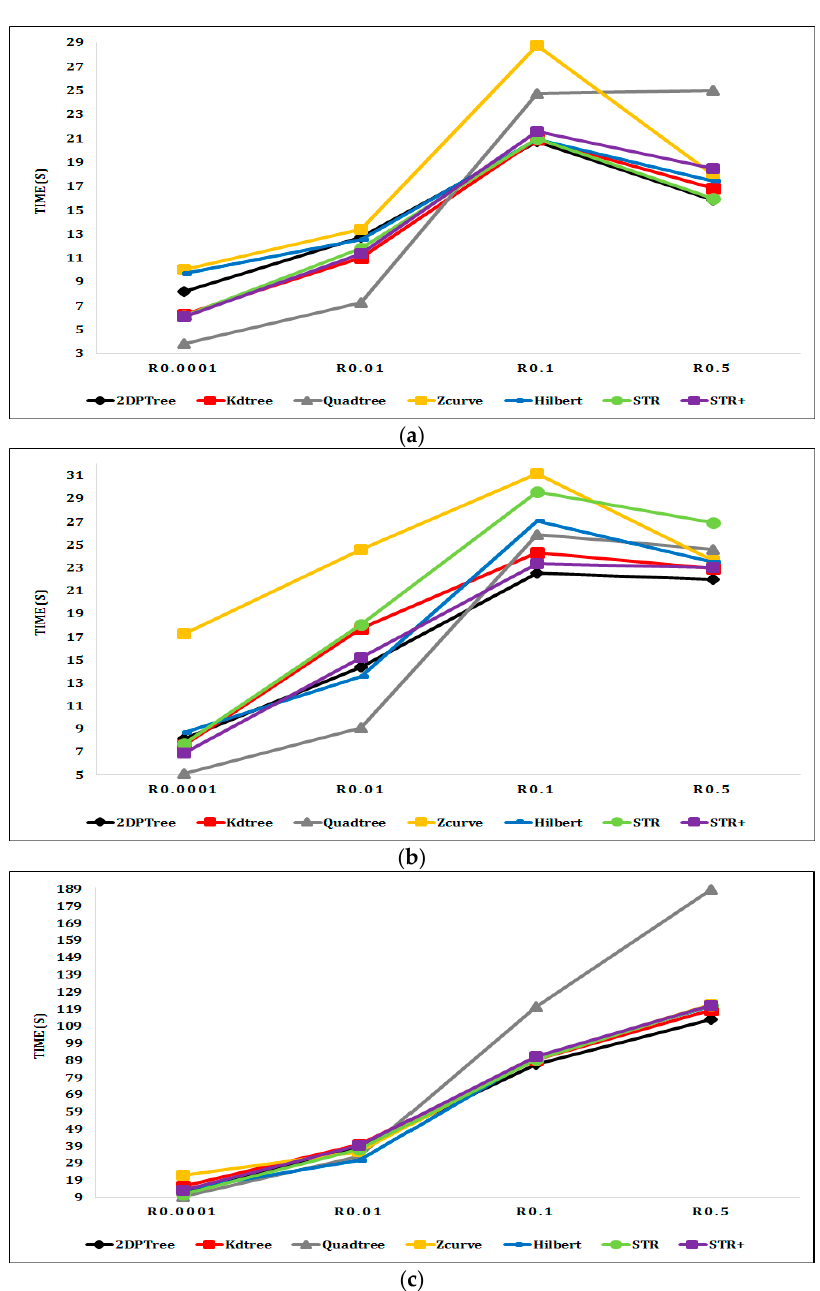
Figure 8. Range query execution time for indexed real datasets: ( a ) Query window area equal to 0.01%, 1%, 10%, and 50% of the Sports dataset area; ( b ) query window area equal to 0.01%, 1%, 10%, and 50% of the Cities dataset area; ( c ) query window area equal to 0.01%, 1%, 10%, and 50% of the Buildings dataset area.